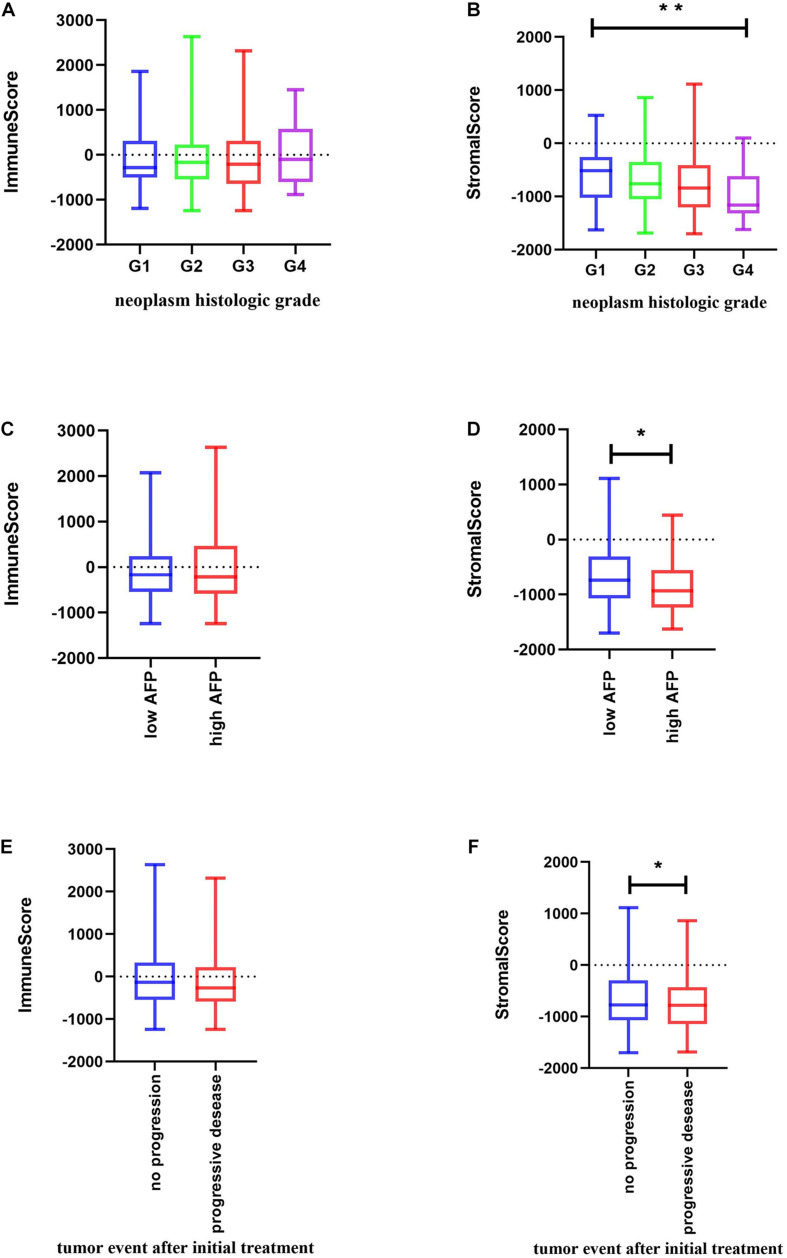
Relationship between immune and stromal scores and HCC clinical and pathological data. (A,B) Distribution of immune and stromal scores of HCC grades. (C,D) Distribution of immune and stromal scores of AFP value of HCC. AFP is divided into high and low groups at the limit of 400 ng/mL. (E,F) Distribution of immune and stromal scores of new tumor event after initial treatment of HCC. Unpaired t-test was used to compare two groups of continuously distributed variables. Jonckheere–Terpstra test was used to compare three or more groups of continuously distributed variables. ∗P < 0.05 and ∗∗P < 0.01.